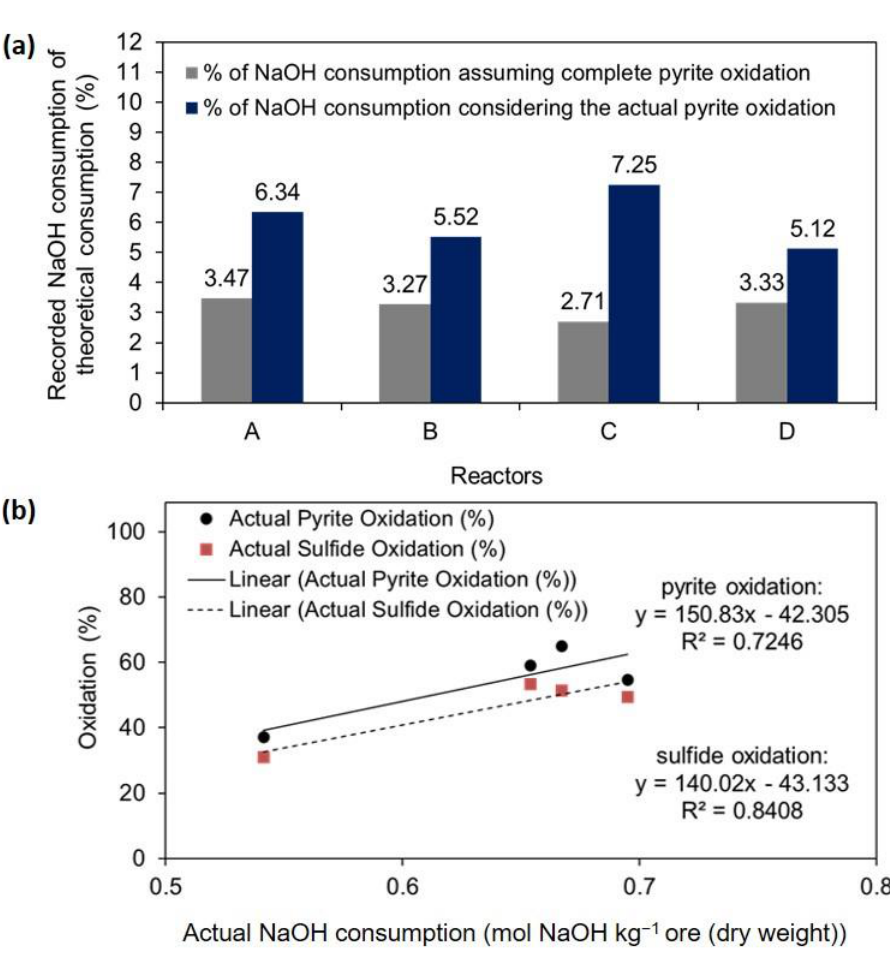
Figure 7. ( a ) Percent of recorded NaOH consumption versus theoretical NaOH consumption assuming complete pyrite oxidation or actual pyrite oxidation for the pyrite oxidation experiment; ( b ) relationship between actual pyrite oxidation or sulfide oxidation and the actual NaOH consumption in the experiment.